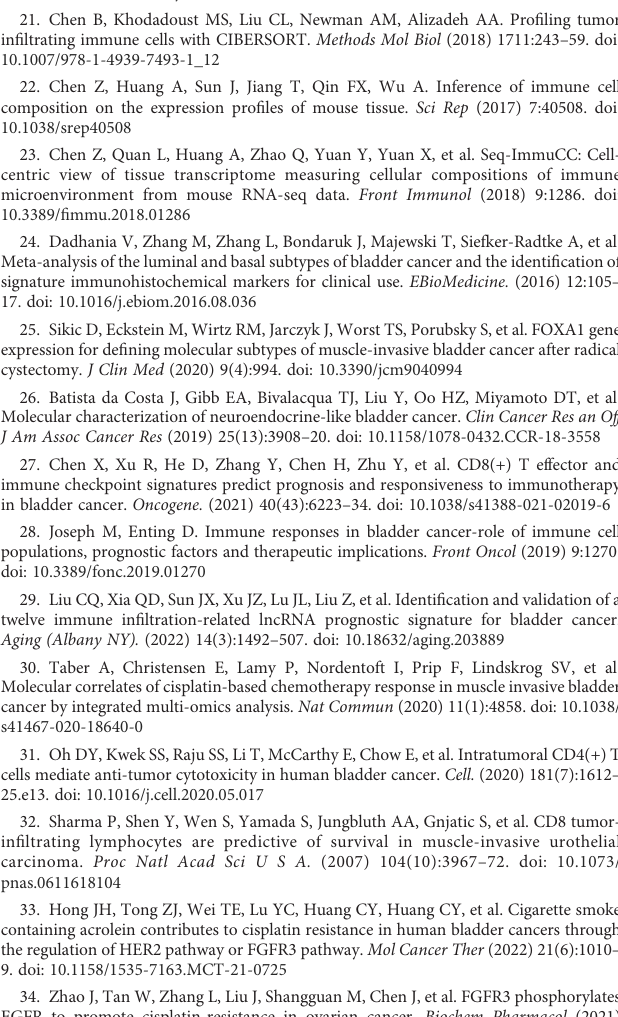
SUPPLEMENTARY FIGURE 3 IHC of cytokeratin 5 in the BURP lines. BURP-12, -17, -18, -21, -24, -25BaSq expresshighlevels ofcytokeratin 5.BURP-16SR andBURP-19NE donotexpress cytokeratin 5. Cytokeratin 5 is expressed by the basal layer in the mouse bladder (control). Scale bars equal 50µm. SUPPLEMENTARY FIGURE 4 Comparison of male and female Ba/Sq BURP tumor lines. PCA plot derived from total transcriptomes of Ba/Sq BURP tumor lines. Each data point represents an individual tumor, with the shape representing the BURP tumor line and the color representing the sex of mouse from which the tumor line was derived. Top two PCs explaining majority of variation are shown.